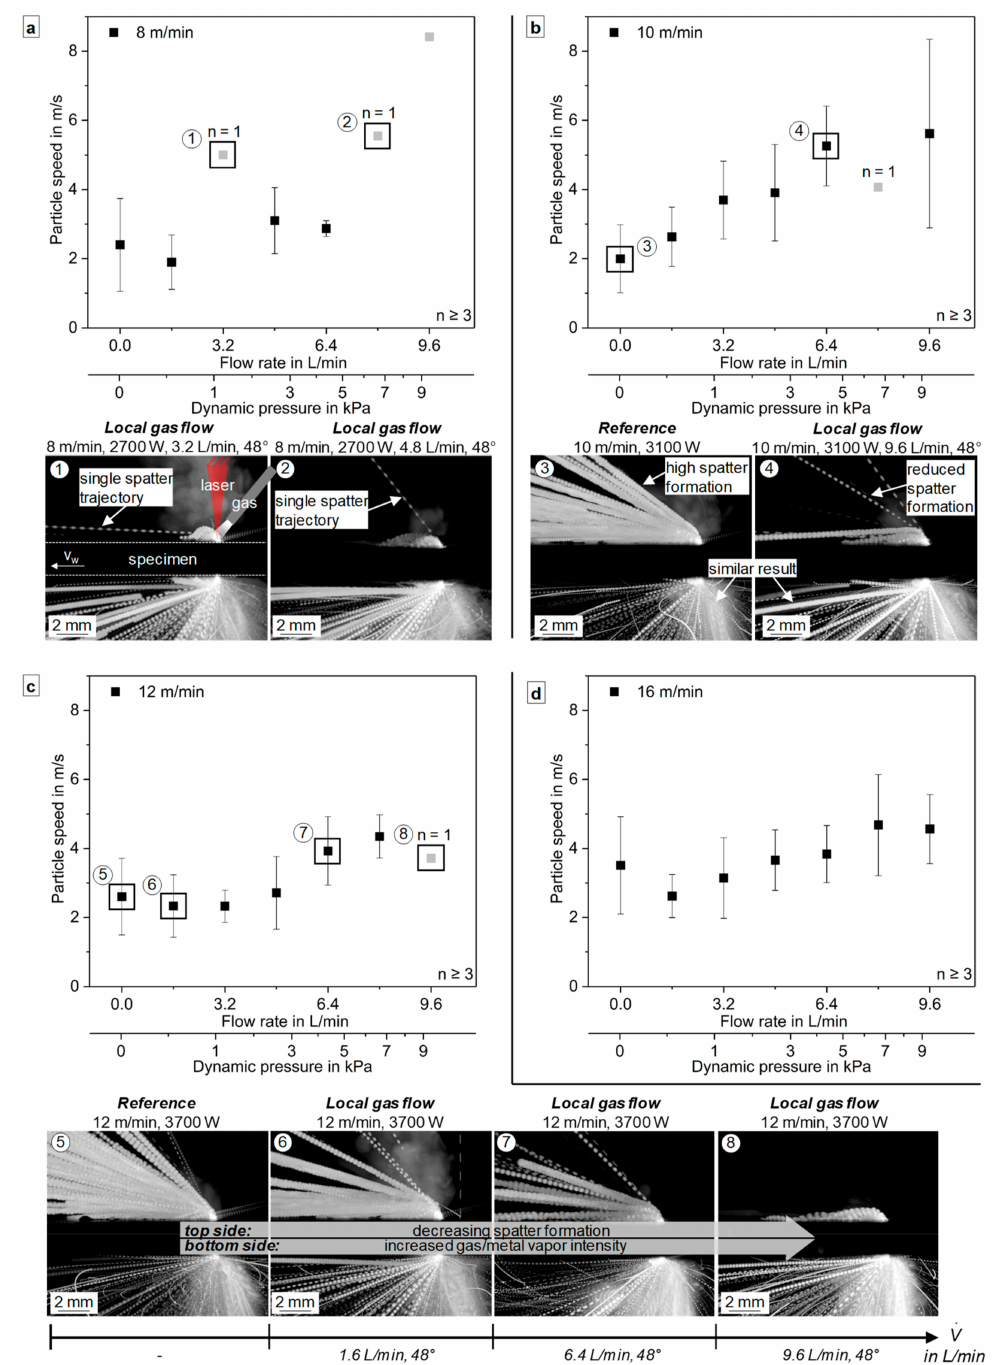
Figure 7. Top-sided particle speed depending on flow rate for welding speeds of: ( a ) 8 min; ( b ) 10 m / min; ( c ) 12 m / min and ( d ) 16 m /